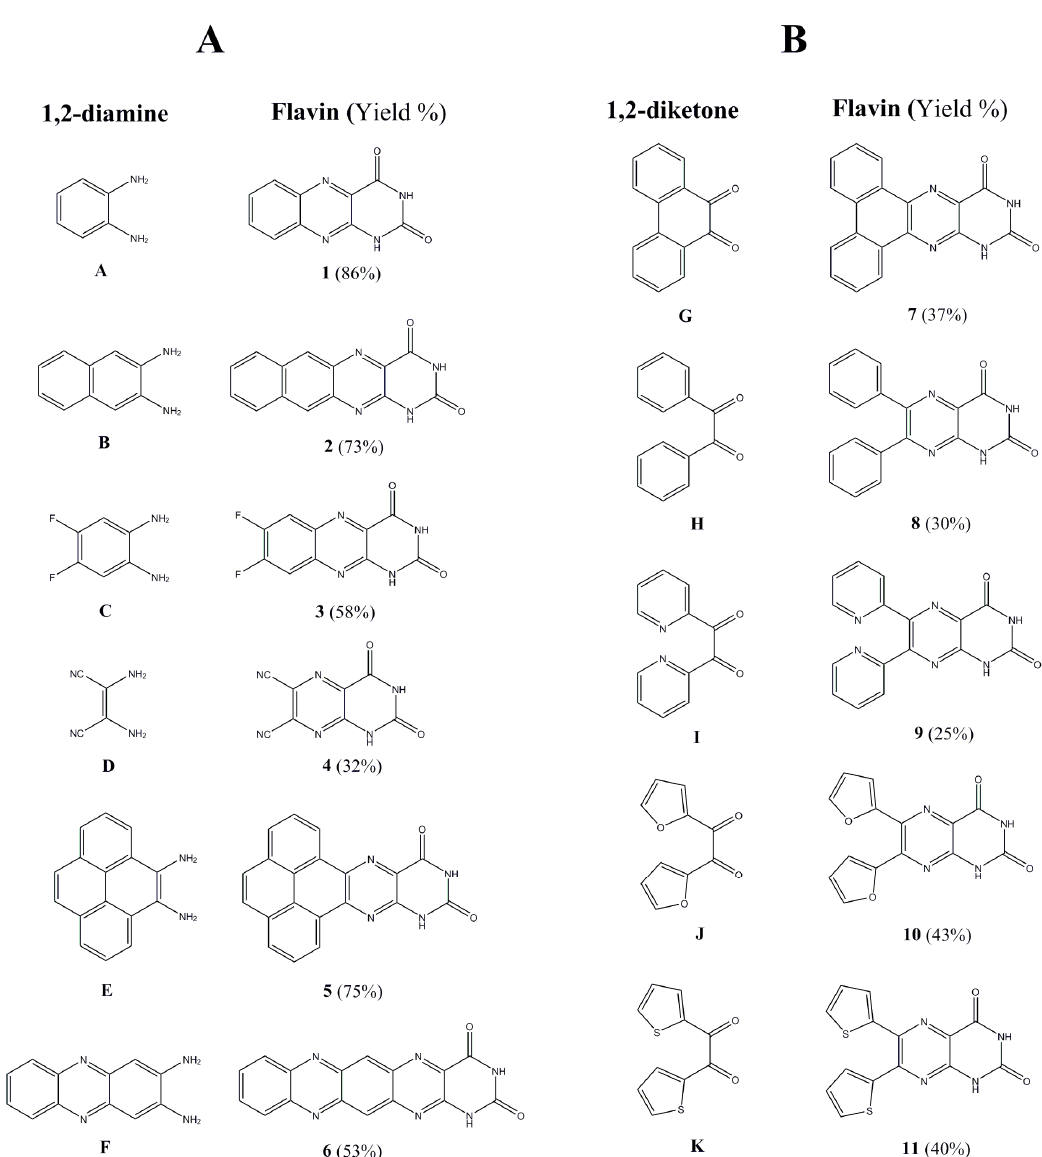
Figure 1. Compounds under investigation, synthetized by Approach A and Approach B.